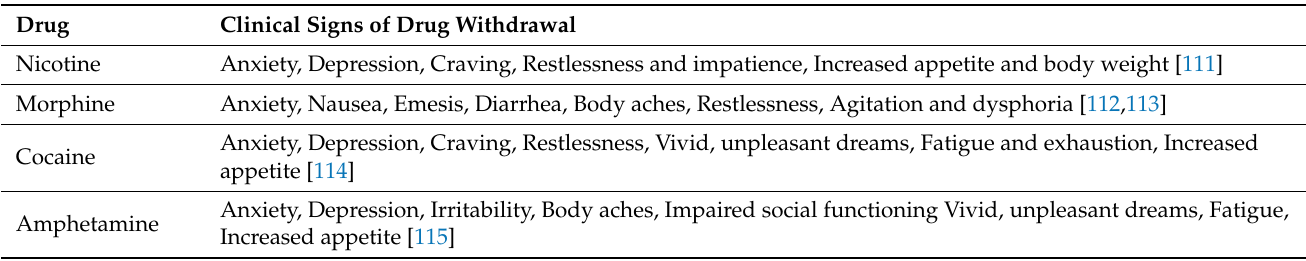
Table 3. Clinical signs and symptoms as a consequence of various drugs of abuse in activation of CaMKII and ERK signaling